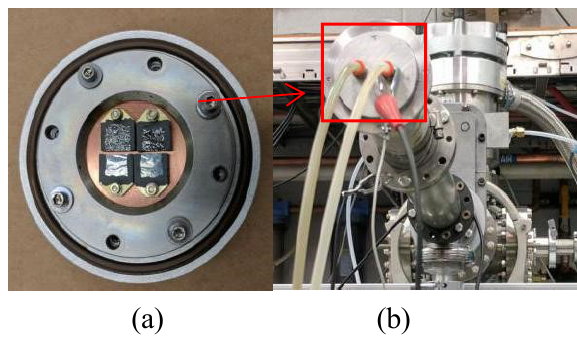
Fig. 1. Sample assembly. (a) Samples loaded on holder. Water goes through the bottom flange, behind the copper plate; (b) Irradiation line. The 2 plastic tubes belong to water cooling system.